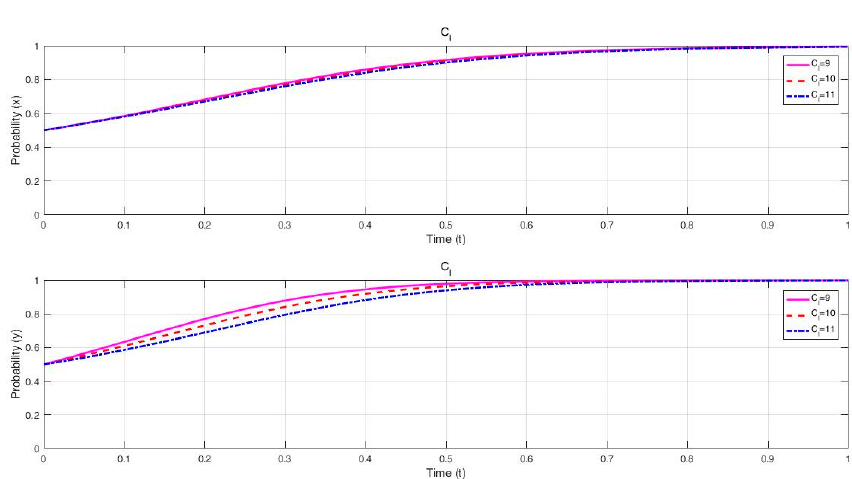
Figure 7. The impact of G c on the game.